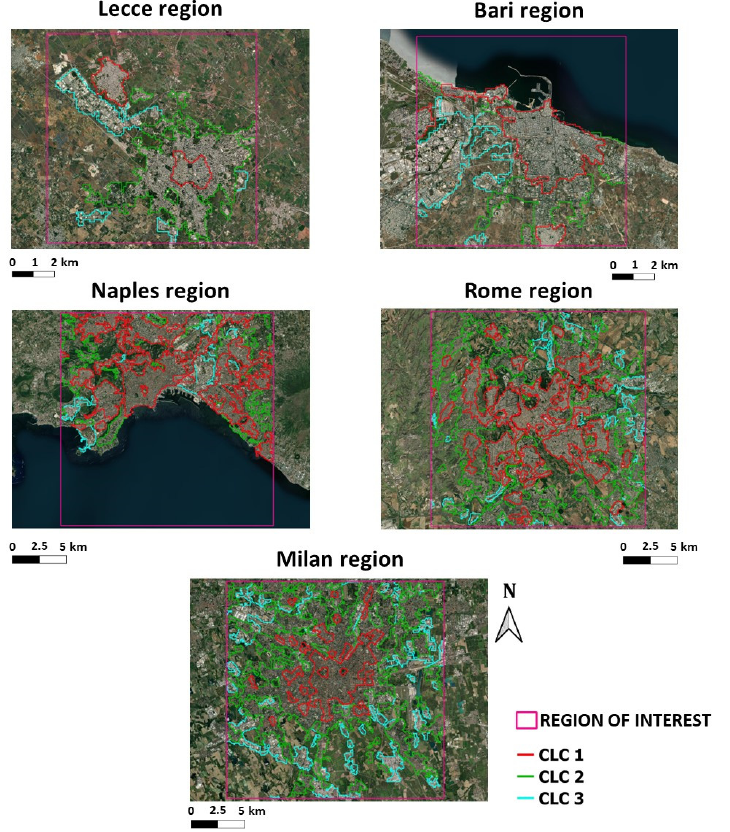
Figure 3. Maps showing the CLC areas employed to evaluate the spatially ‐ averaged values of morphological parameters (base maps: phological parameters (base maps: https://server.arcgisonline.com/ArcGIS/rest/services/World_ https://server.arcgisonline.com/ArcGIS/rest/services/World_Imagery/MapServer/tile/{z}/{y}/{x}, Imagery/MapServer/tile/\{z\}/\{y\}/\{x\}, accessed on 14 December accessed on 14 December 2022).